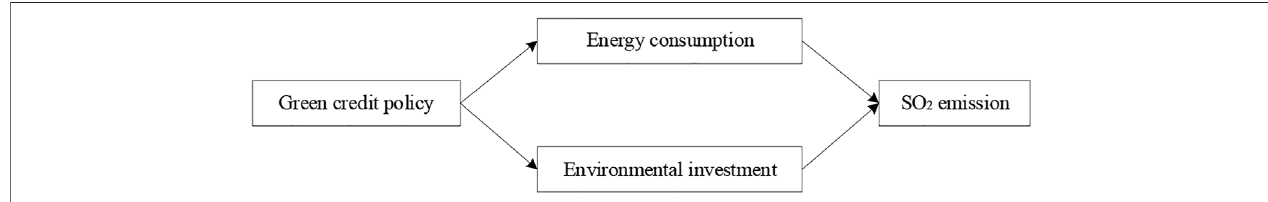
FIGURE 1 | Mechanisms that how green credit policy affect SO 2 emission.